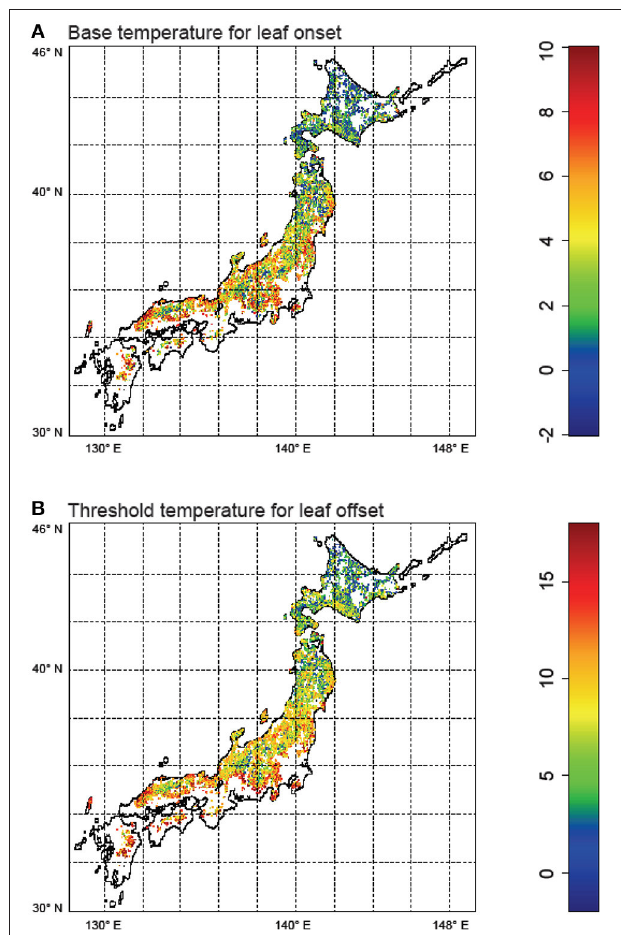
FIGURE 4 | Results of data assimilation using the particle filter for Japanese broadleaf deciduous forests. (A) Optimized base temperature ( ◦ C) for leaf onset ( T onset ), and (B) Optimized threshold temperature ( ◦ C) for leaf offset ( T offset ). The maps were created by R 3.2.4